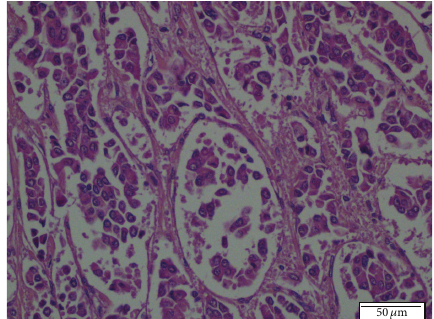
Figure 8: Ki 67 proliferation index is 5-6% in tumor cells. IHC staining, ×